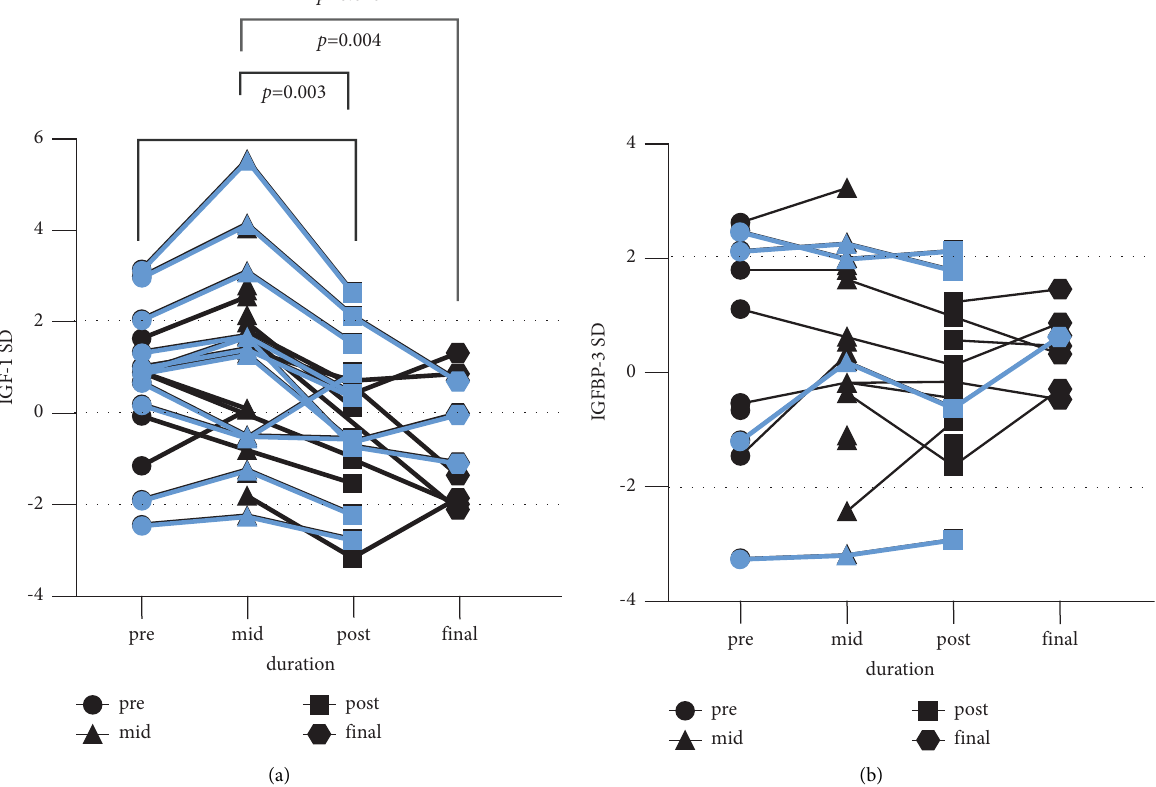
Figure 1: Serum IGF1 SDs/IGFBP-3 SDs in 30 boys with hCG-induced precocious puberty at diagnosis (pre), at the time when hCG level normalized (mid), at the end of multidisciplinary therapy to hCG-secreting tumors (post), and at the fnal follow-up visit (fnal). (a) IGF-1 SDs in diferent therapeutic phases. (b) IGFBP-3 SDs in diferent therapeutic phases. A total of 11 boys received IGF1 assessment and 4 boys received IGFBP-3 SD assessment (corresponding with Table 1) in the whole therapeutic process and they were marked with blue